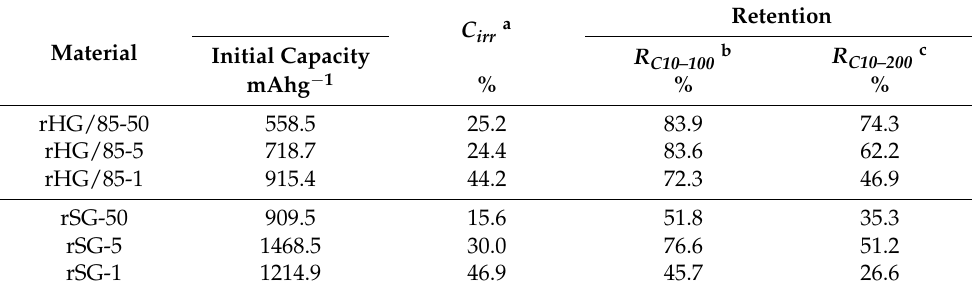
Table 4. Initial capacity, irreversible capacity in the 1st cycle (C irr , %) and capacity retention (R, %) obtained from the galvanostatic cycling at a current density of 500 mA g − 1 of rSG- and rHG/85-based electrode